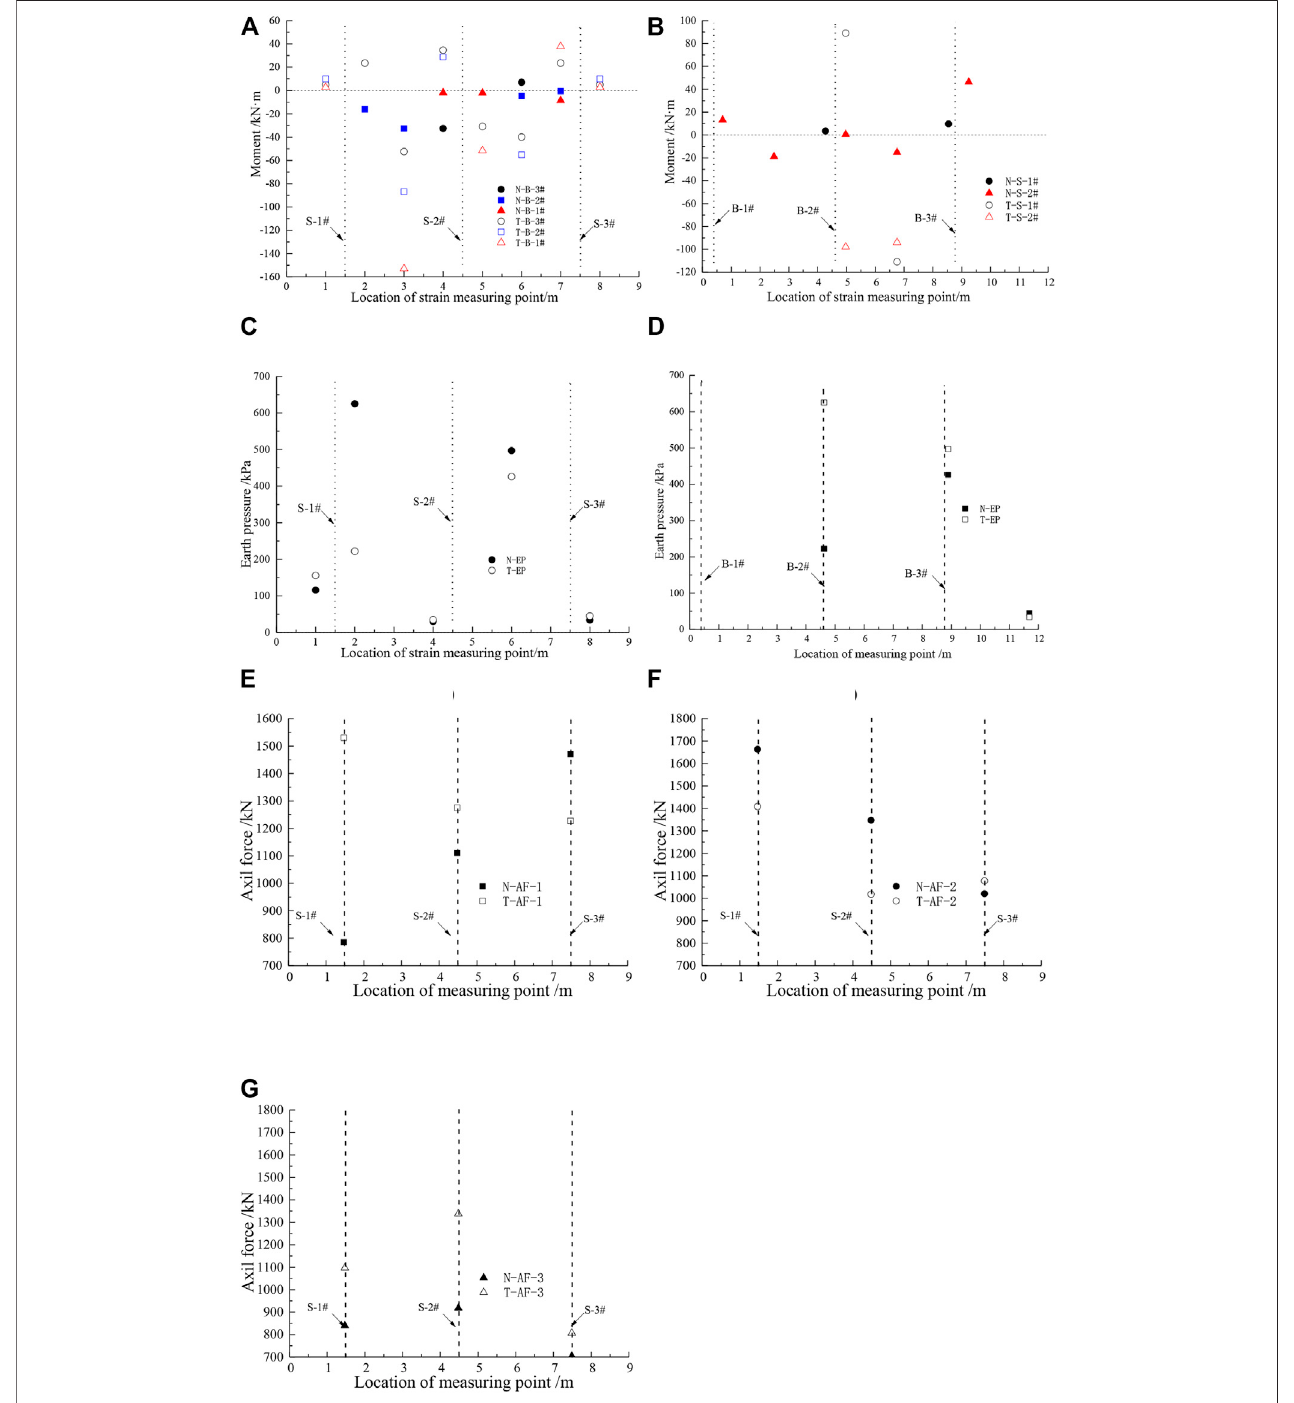
FIGURE 11 | Moment of frame beam: (A) beams, (B) strings; earth pressure: the bottom of the (C) beam, (D) string and axial force of the anchor cable: (E) 1#, (F) 2#; (G) 3#.